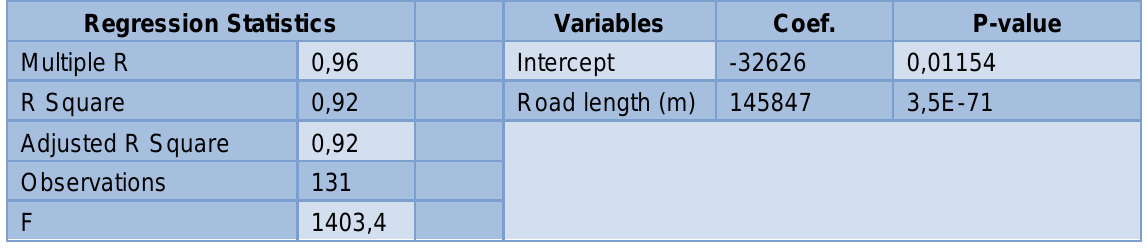
Table 15 Multiple regression results among total project cost and road length